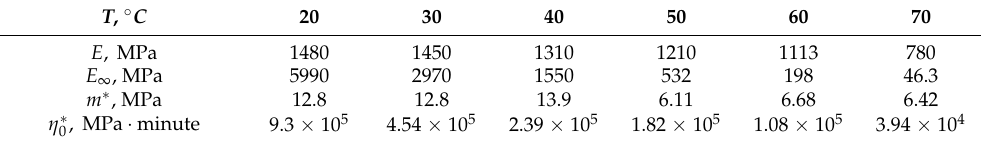
Table 2. Elastic and rheological parameters of recycled polyvinyl chloride at different temperatures.